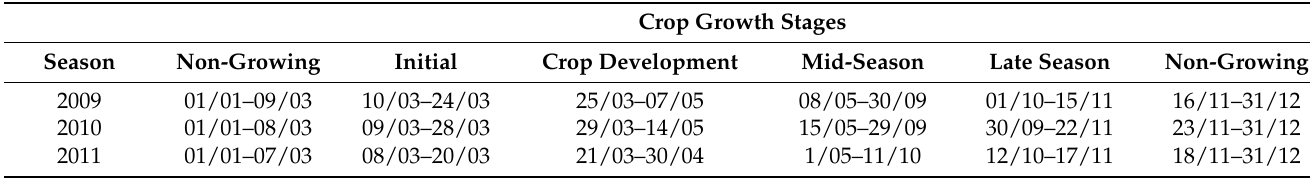
Table 1. Dates of the beginning and end of the crop growth stages. Crop Growth Stages